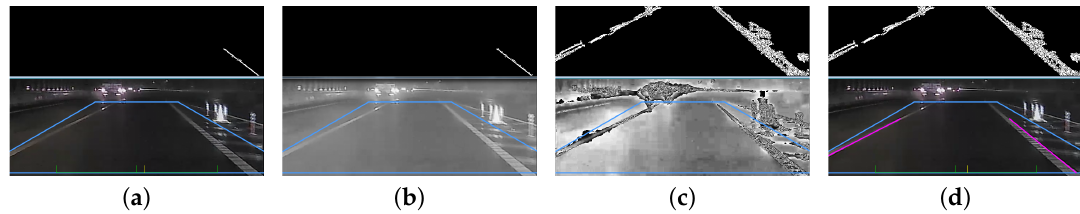
Figure 3. The comparison of conventional gamma correction and proposed gamma correction results. ( a ) The detection result with no gamma correction; ( b ) the detection result using conventional gamma correction; ( c ) the input image using the proposed gamma correction; ( d ) the result using the proposed gamma